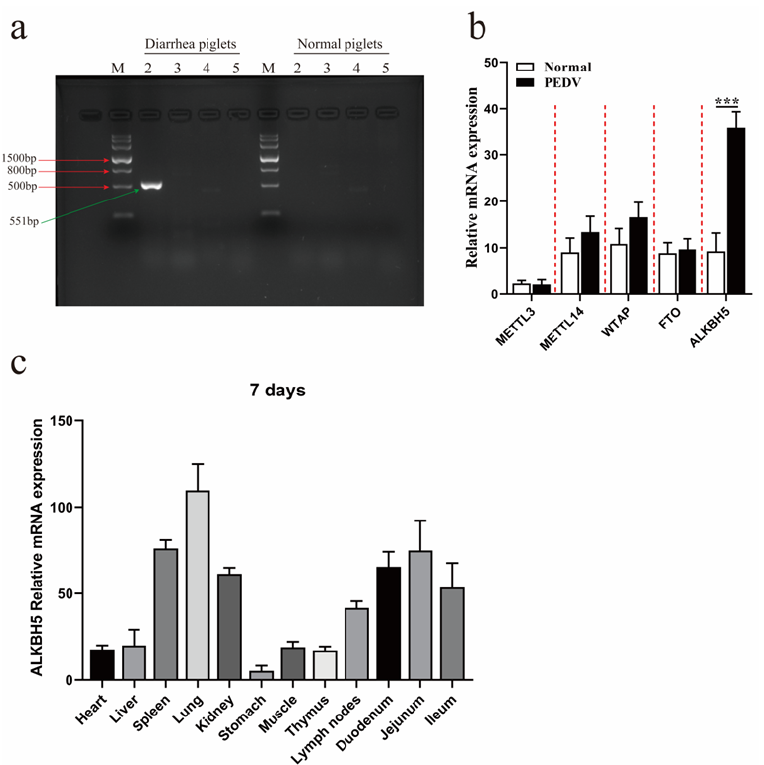
Figure 1. Increased expression of ALKBH5 in the lung tissues of piglets after PEDV infection. ( a ) Gel picture for PCR results against distinct marker genes against different viruses in the lung tissues of individual piglets with diarrhea, as well as normal piglets. M: Marker Ⅲ molecular weight standard. Lanes 2–5 represent PEDV-M, PDCoV-N, PoRV-VP6, and TGEV-S1, respectively. ( b ) Expression level of m 6 A-related modifying enzyme genes in lung tissues of normal and PEDV-infected piglets. Normal: normal piglets; PEDV: PEDV-infected piglets. ( c ) Expression profile of ALKBH5 in twelve different tissues of normal 7-day-old piglets. At least three biological replicates are analyzed for each group. Data are presented as the mean ± SD; *** p < 0.001.